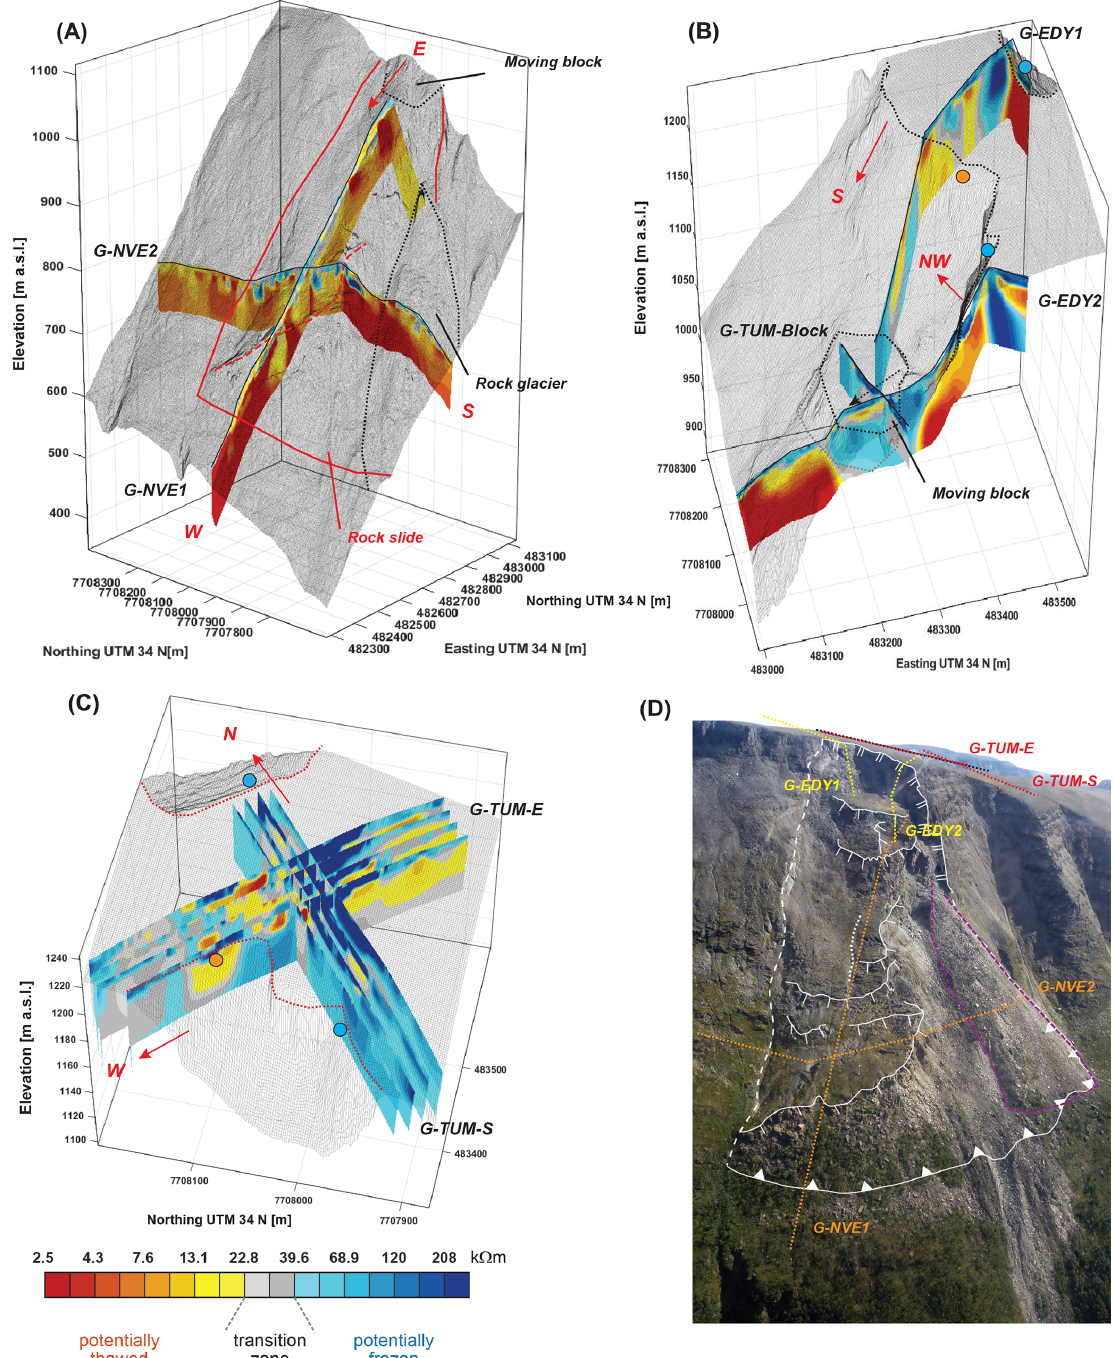
Figure B1. 3D plots showing the ERT profiles in relation to topography for Gámanjunni-3. (a) G-NVE1 and G-NVE2. The rockslide (red) and rock glacier (black) are delineated. The black stippled line indicates the lower limit of the moving block. (b) The rock wall profiles G-EDY1 and G-EDY2 and the ERT profile over the moving block (G-TUM block). The moving block is indicated by the black line, as is the crest between the rock wall and top plateau. The circles show the location of the rock wall loggers (orange: > 0 ◦ C in annual average, blue: < 0 ◦ C. (c) Quasi-3D profiles on the plateau (G-TUM-S and E). The red line shows the crest, with the circles like in (b) . (d) Oblique image of the instability at Gámanjunni-3 as in Fig. 2a. The approximate location of the ERT profiles is drawn on the images. © NGU.